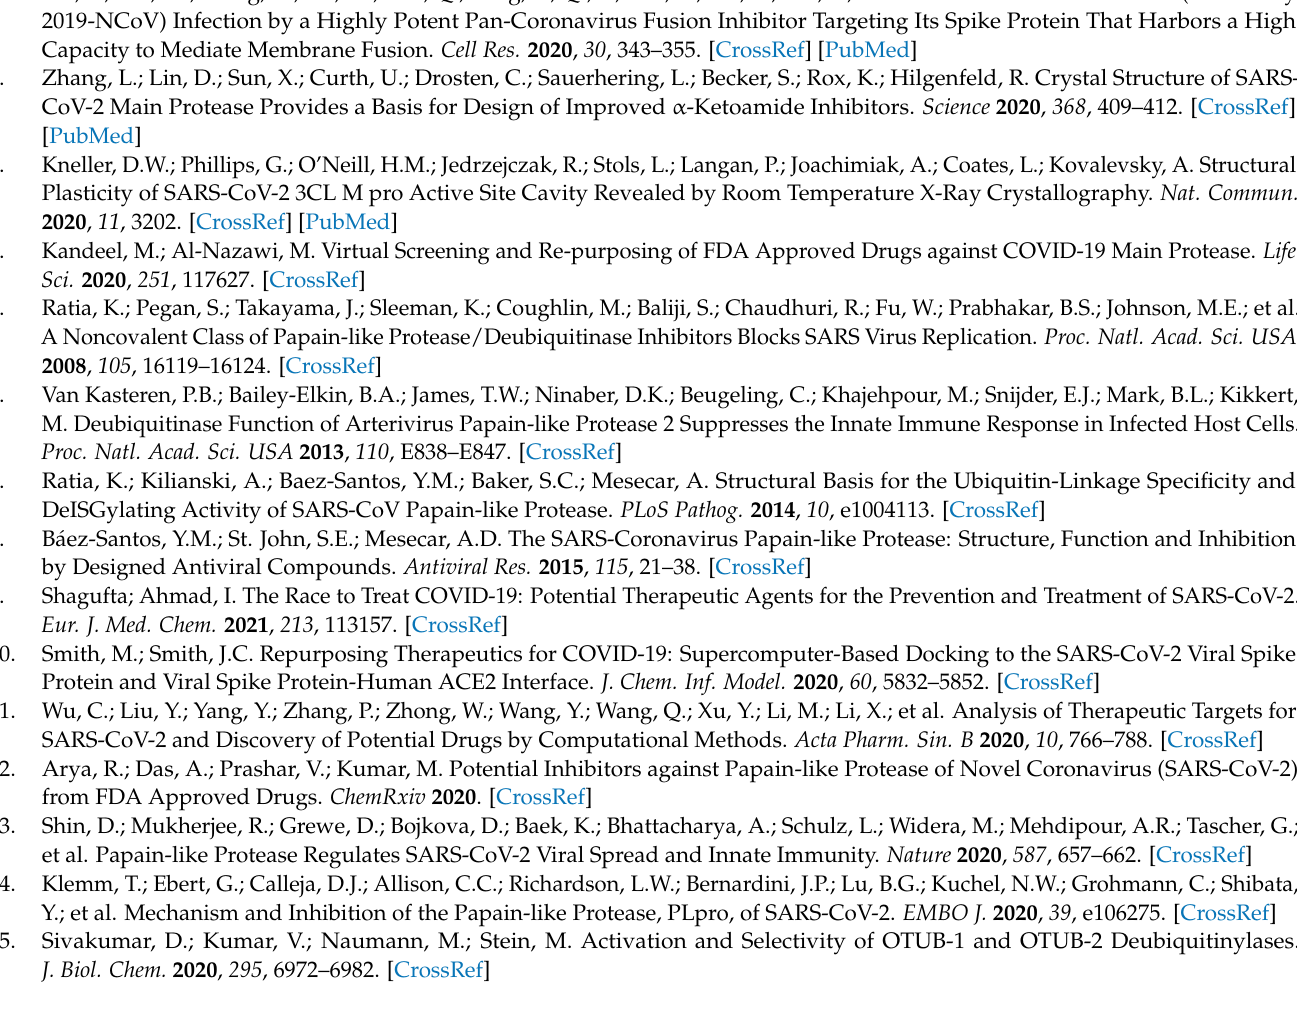
Figure S20. Molecular Dynamics studies of OTUB-2 to show the RMSD of protein and Ligand over time for Compound 5 (left) and Compound 6 (right). Figure S21. Cov-2-PLpro with its inhibitors in the X-ray structures (ligand carbon in grey) and refined with MD simulations (ligand carbon in green). (A) 6WUU with peptide inhibitor VIR250 and B) 6WX4 with peptide inhibitor VIR251.Figure S22. Dominating non-covalent protein-ligand interactions of the peptide inhibitors (A) VIR250, (B) VIR251 with the PLpro SARS-CoV-2 during MD refinement simulations. Persistence of interactions is given in percent of simulation